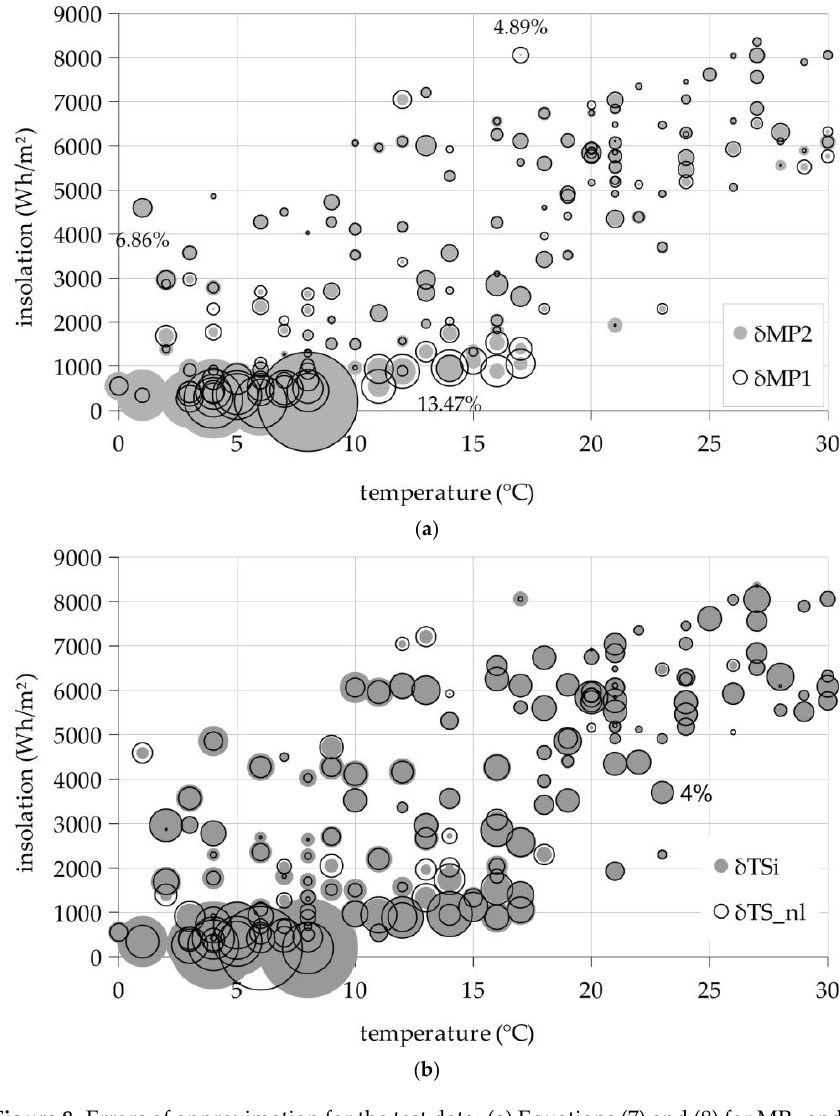
Figure 8. Errors of approximation for the test data: ( a ) Equations (7) and (8) for MP 1 and MP 2 mod- els; ( b ) TS system with triangular membership functions of the ANFIS model ( δ TSi) and the TS system with nonlinear membership functions given by Equation (21) ( δ TS_nl).